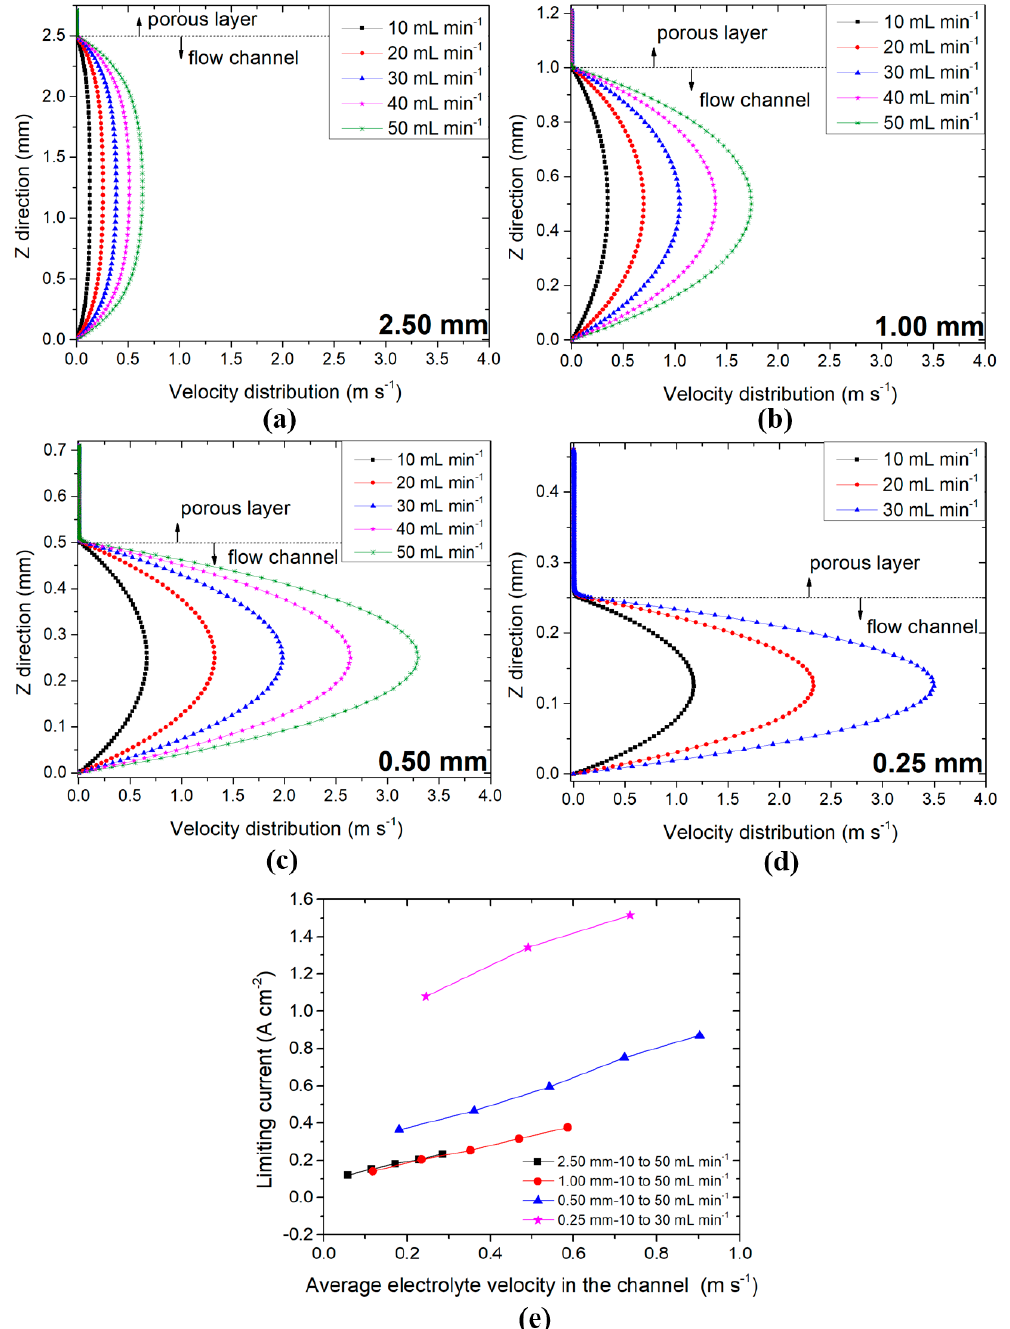
Figure 3. Predicted electrolyte velocity distribution at a cut line in the center of the electrode and channel domain: ( a) 2.5 mm ( b ) 1 mm ( c ) 0.50 mm ( d ) 0.25 mm and ( e ) correlation between average channel velocity and measured limiting currents.